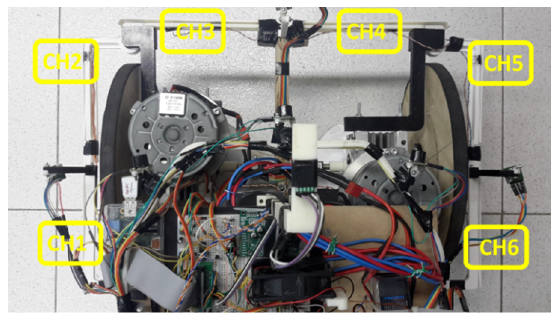
Figure 3. Distribution of contact switches.